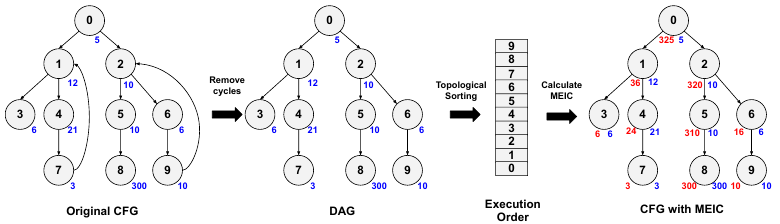
Figure 4. Overview process of calculating Maximum Expectation of Instruction Count